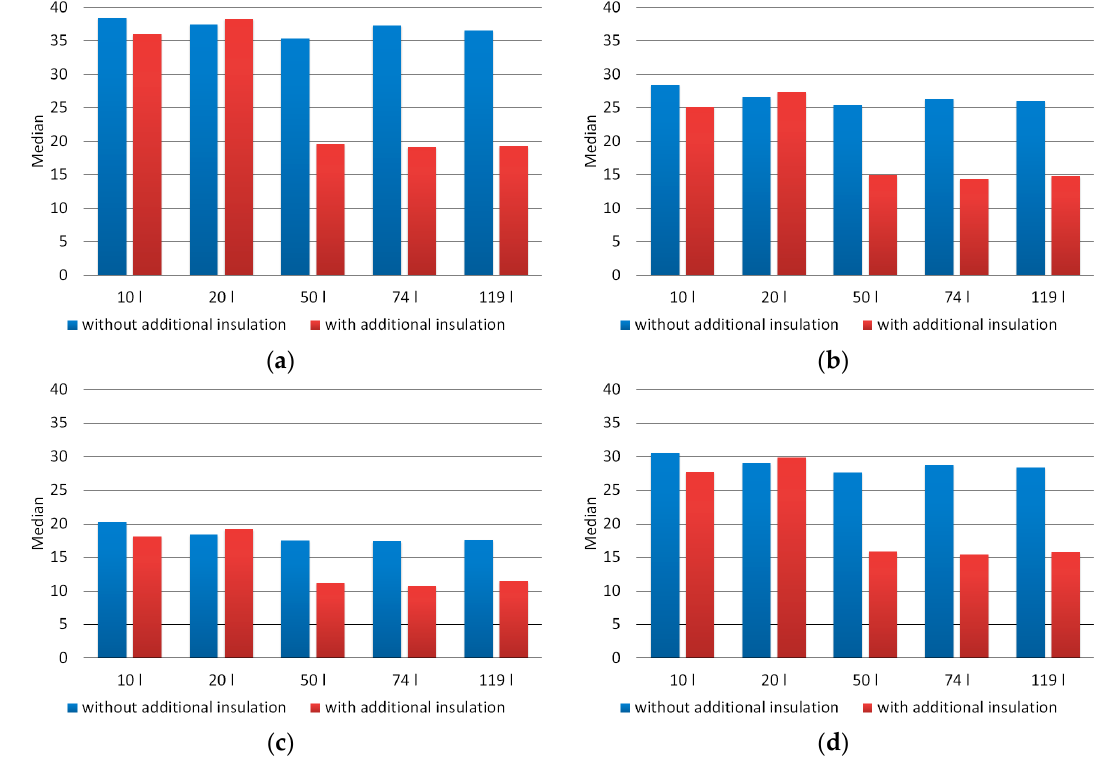
Figure 6. Median brightness of the pixel averaged for images of composted material ( a )—component R, ( b )—component G, ( c )—component B, ( d )—grayscale.